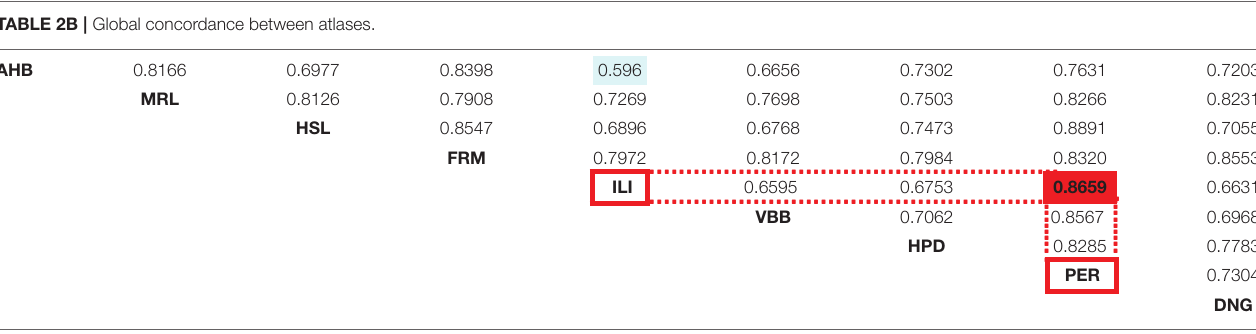
TABLE 2B | Global concordance between atlases.